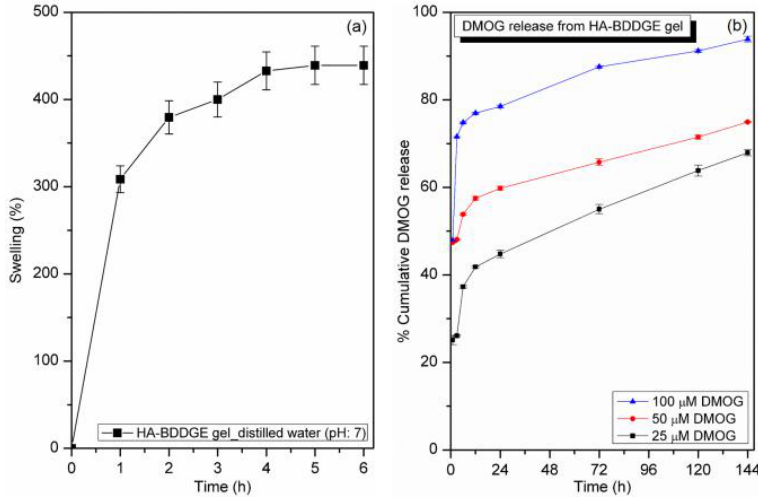
Figure 5. ( a ) Graph of % swelling vs. time for HA-BDDGE patterned gel, and ( b ) in vitro release profile of dimethyloxalylglycine (DMOG) from loaded HA-BDDGE patterned gel over